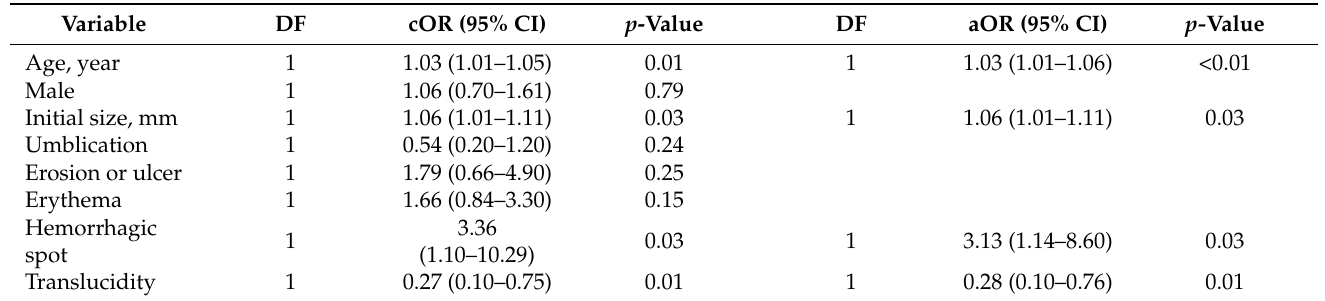
Table 2. Cox regression analysis of endoscopic findings to predict an increase in the size of upper gastrointestinal subepithelial